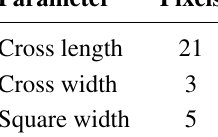
Table 3. Cross parameters according to Figure 4 used during analysis.